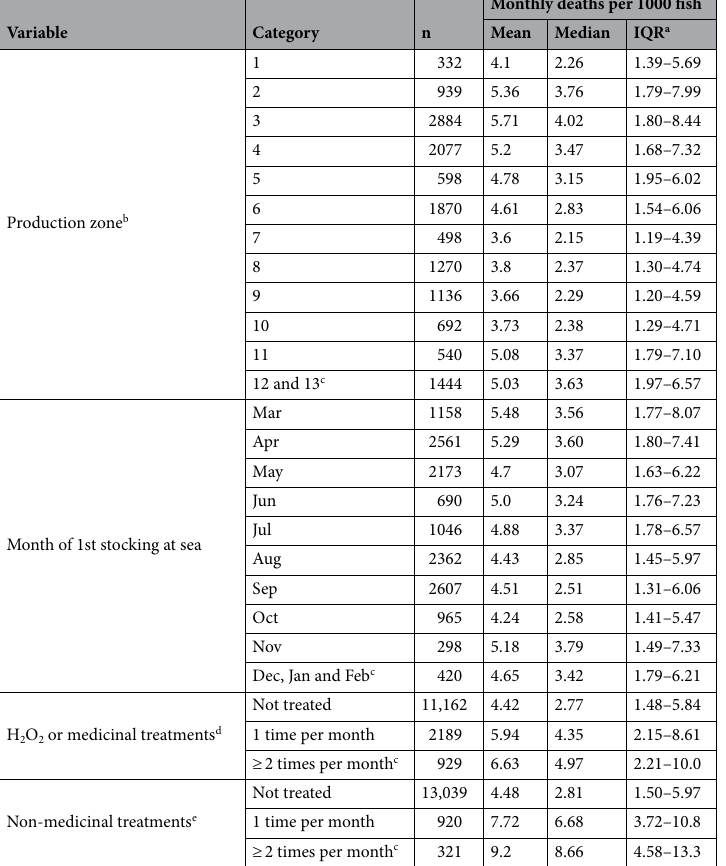
e Removal of sea